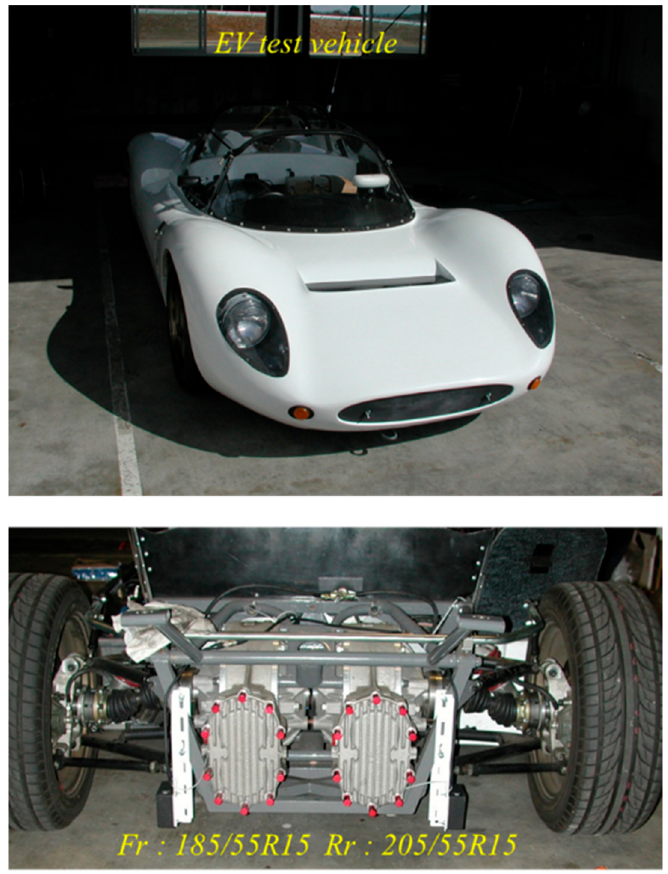
Figure 4. Test electric vehicle equipped with twin motor system.